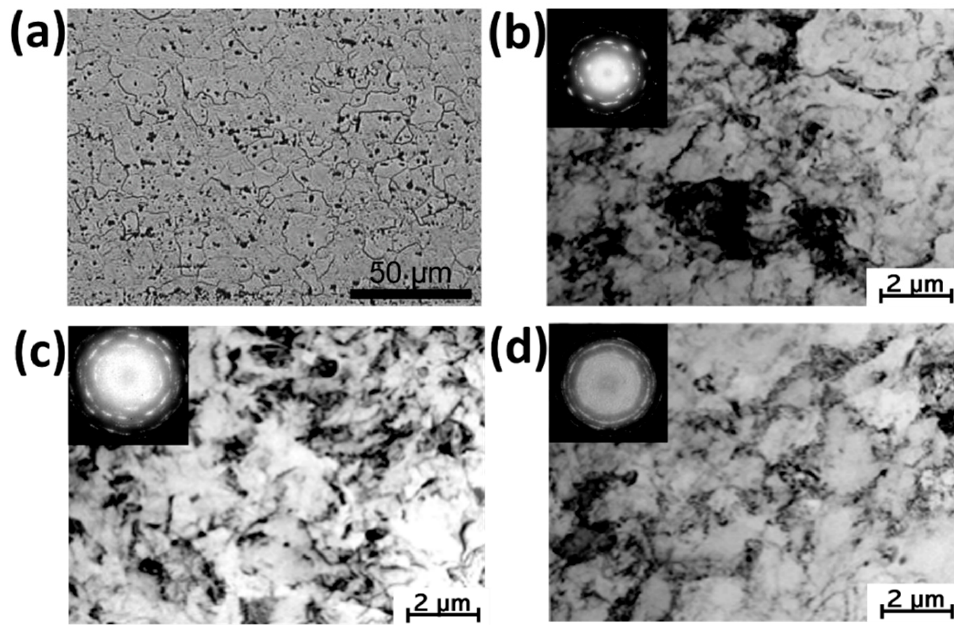
Figure 4. Optical microscopy and bright-field transmission electron microscopy of AA5052 ( a ) for the initial annealed state and ( b – d ) after processing with the CEC method with different numbers of passes: ( b ) the first pass, ( c ) the second pass, and ( d ) the fourth pass.